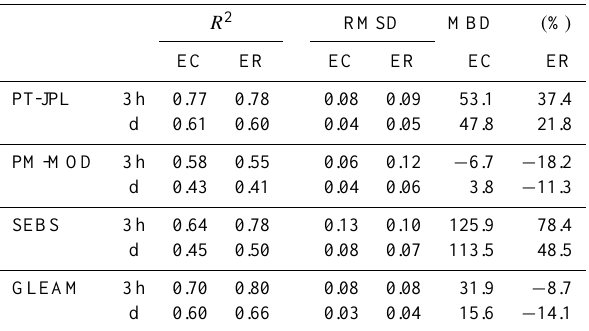
Table 3. Summary of 24 stations average statistics for 3-hourly and daily tower forcing. EC denotes the model agreement with the evap- otranspiration reference from eddy-covariance measurements, and ER is the model agreement with the evapotranspiration reference based on the in situ energy residual. RMSD is given in millimeters per hour for both 3-hourly data (3h) and daily data